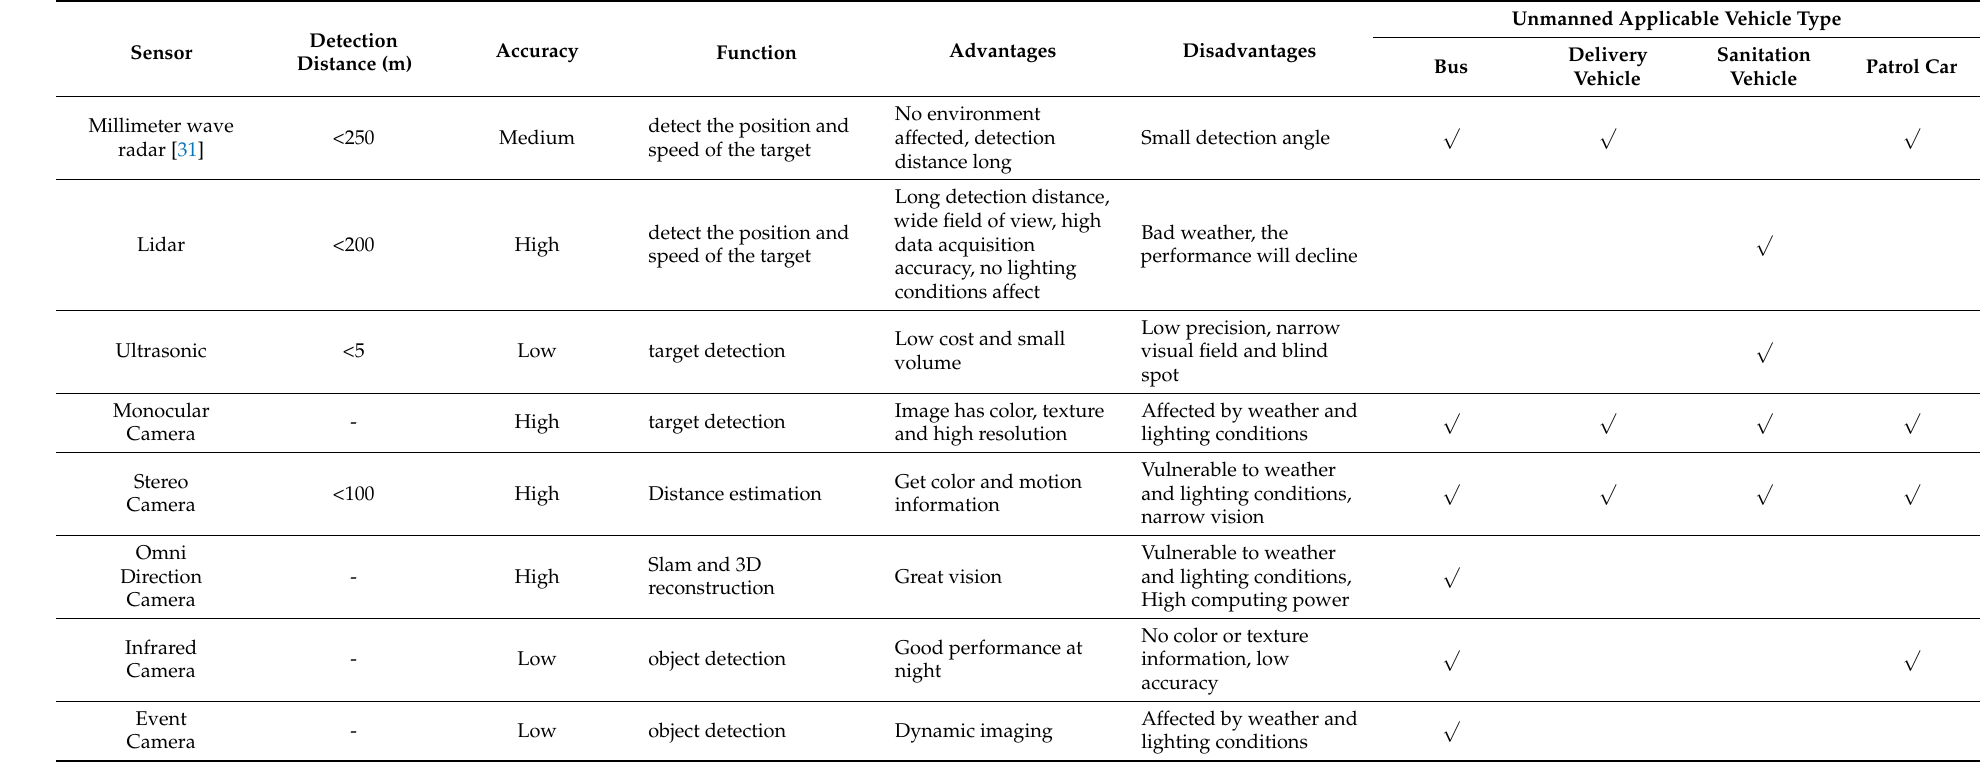
Table 3. Vehicle External Sensor